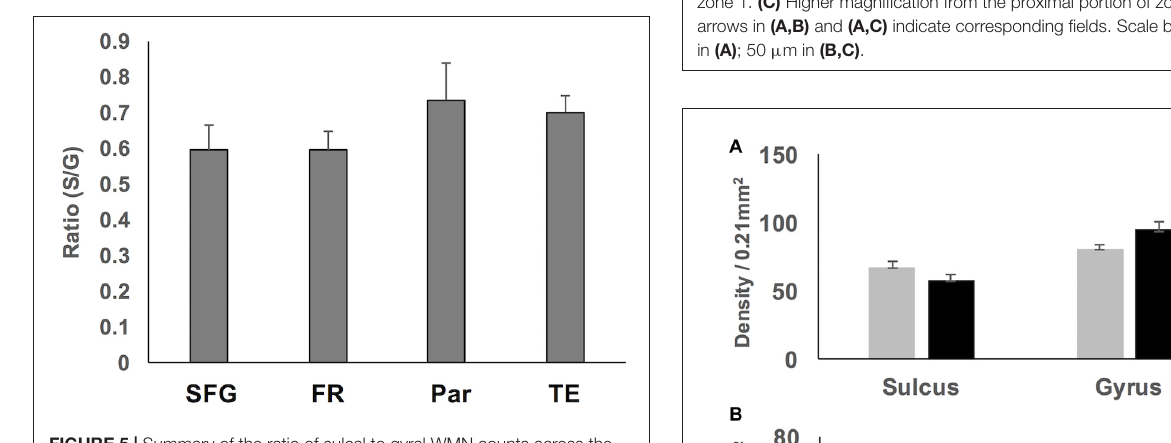
26 ± 3 neurons and, for STG, 28 ± 3 (per 0.25 mm 2 ). There is a small reduction from zone 2 to 3 but otherwise numbers are stable from zone 3 to 4; namely, for zone 3, 12 ± 1 neurons in